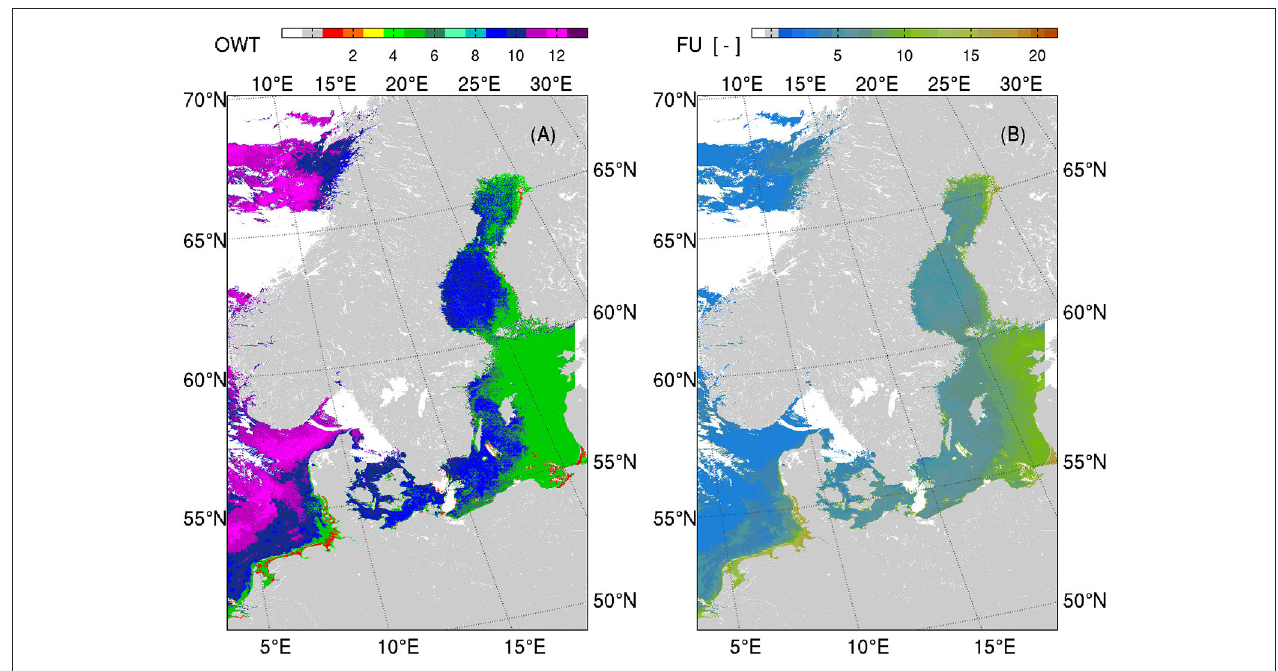
FIGURE 6 | ONNS application to the OLCI scene (20 July 2016, Figure 5). (A) : Optical water type classes with maximum membership. The gray color marks land areas, white shows the cloud mask above water and inland waters, and the other colors correspond to the spectra in Figure 3 . (B) : Retrieved Forel-Ule colors with true color